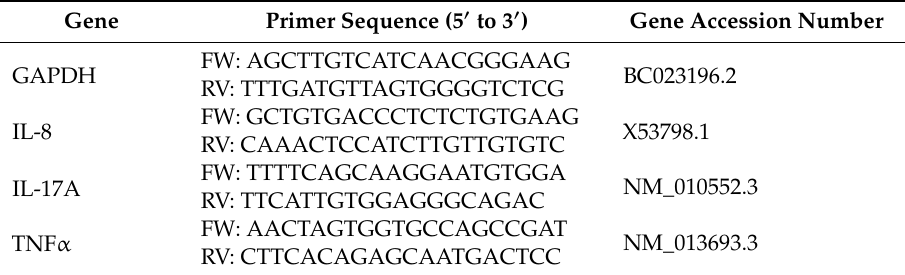
BC023196.2 X53798.1